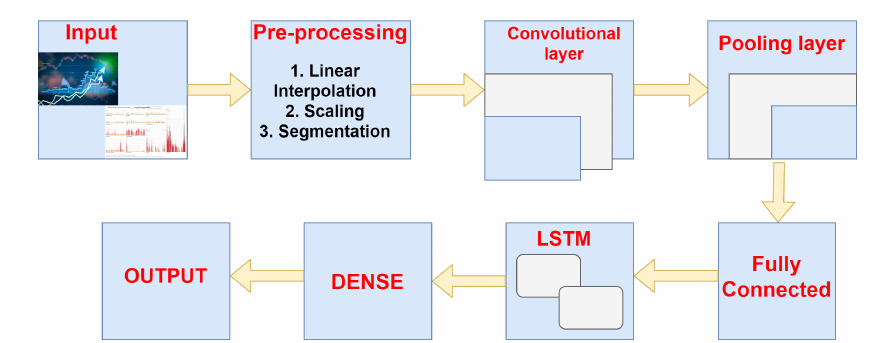
Figure 6. Working of CNN-LSTM.